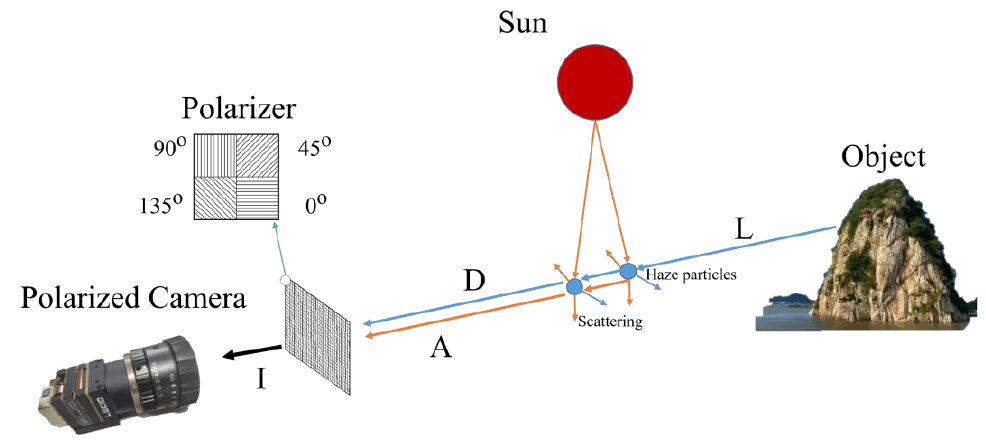
Figure 1. Atmospheric transmission model.